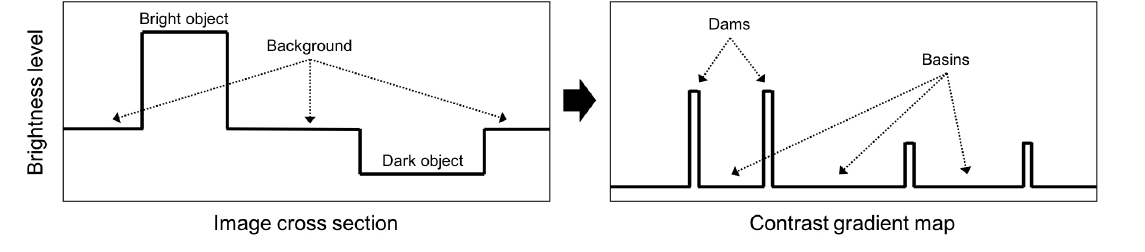
Fig. 2 . Simplified illustration of how a watershed segmentation is performed on a portion of an image containing a bright object and a dark object against a uniform background. The image is first transformed into a contrast gradient map in which dark “basins” represent spectrally homogeneous parts of the image, separated by “dams” of varying height, i.e., brightness, proportionate to the magnitude of spectral contrast between the adjacent image features. Segmentation of the image is achieved by “flooding” the basins to a specified level. In this example, progressive flooding from the bottom up will cause the dark object to be amalgamated with adjacent background objects before the bright object, because the former’s magnitude of contrast with the background is smaller than the